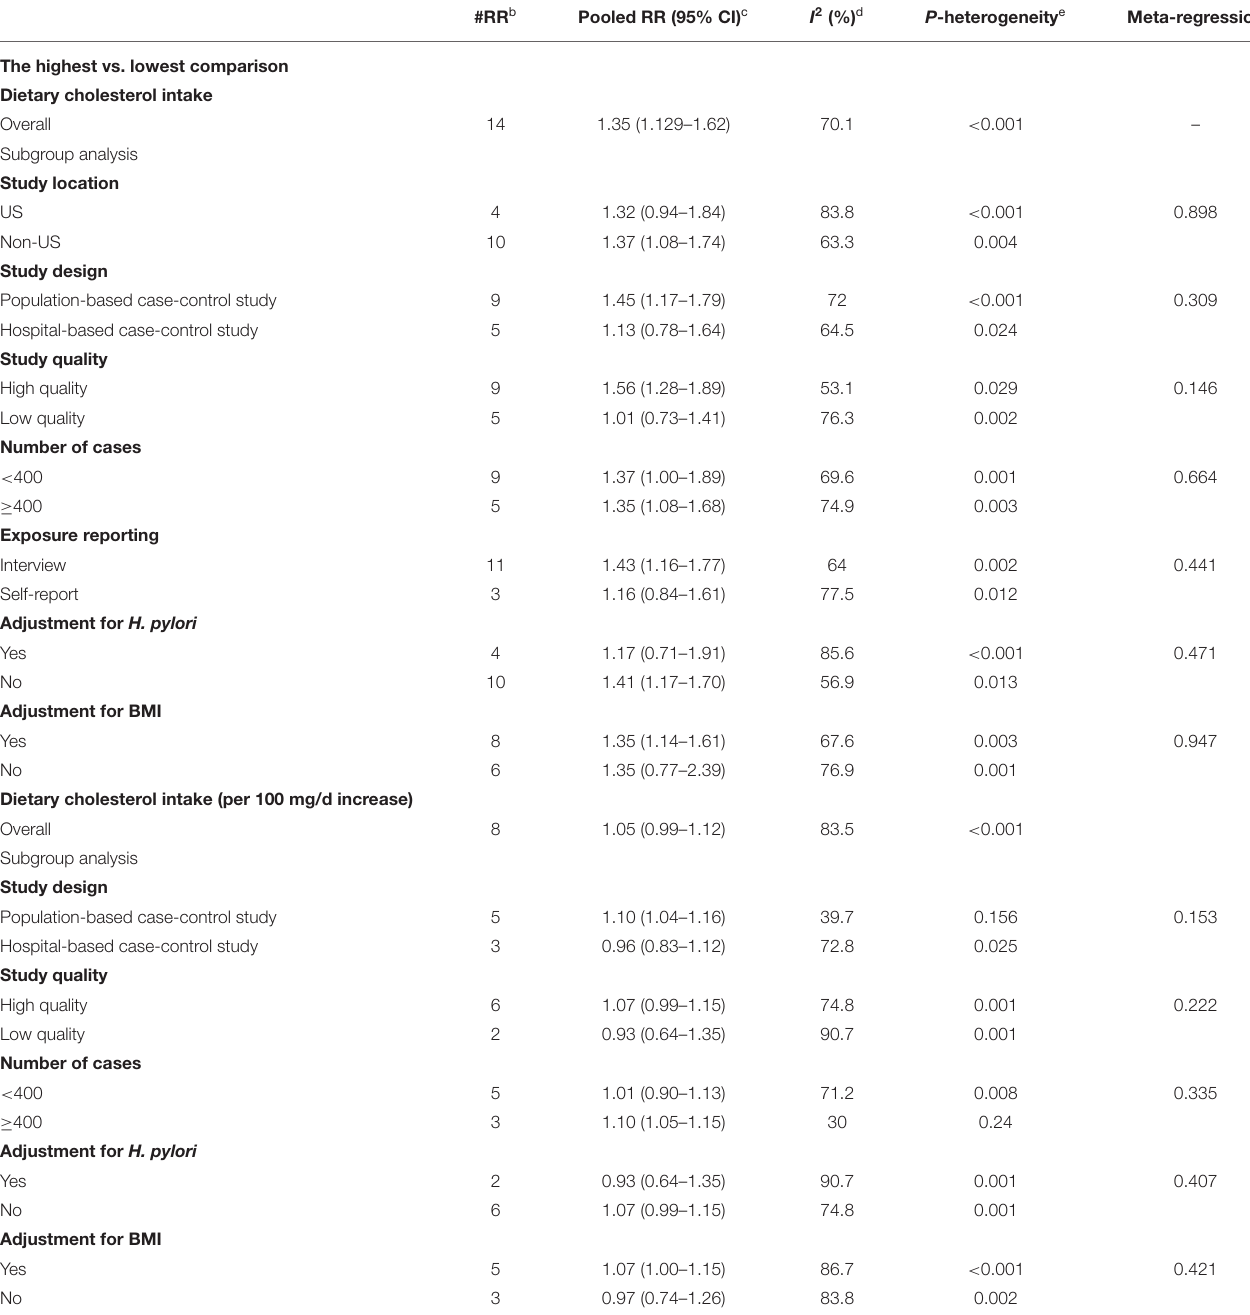
P -heterogeneity e